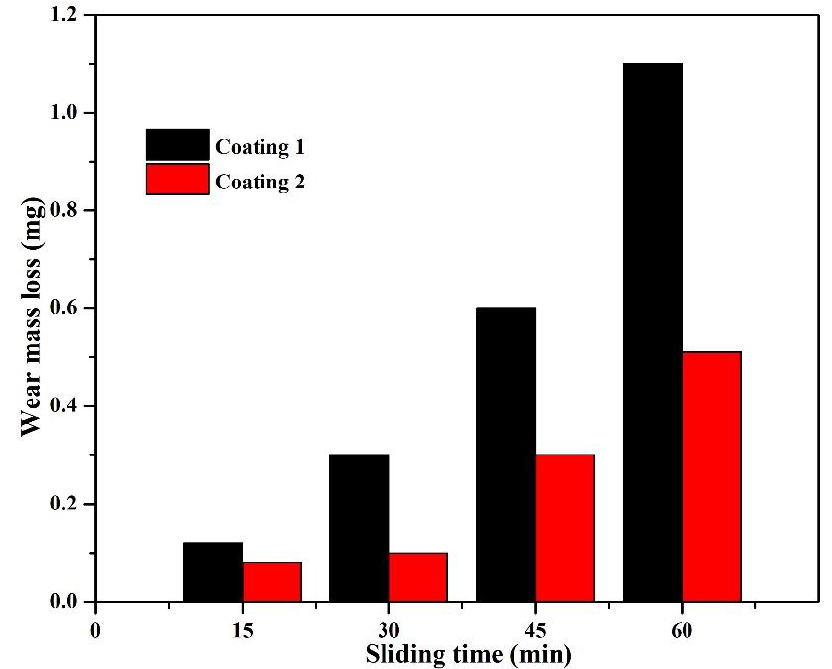
Figure 16. Wear mass loss of Coating 1 and Coating 2.